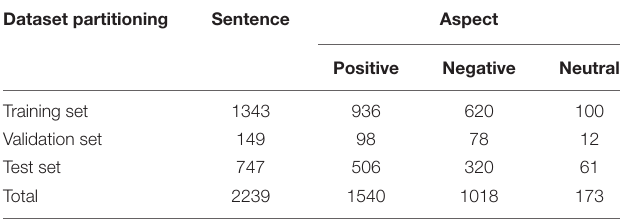
TABLE 4 | Specific distributions of semantic aspects in the service datasets.